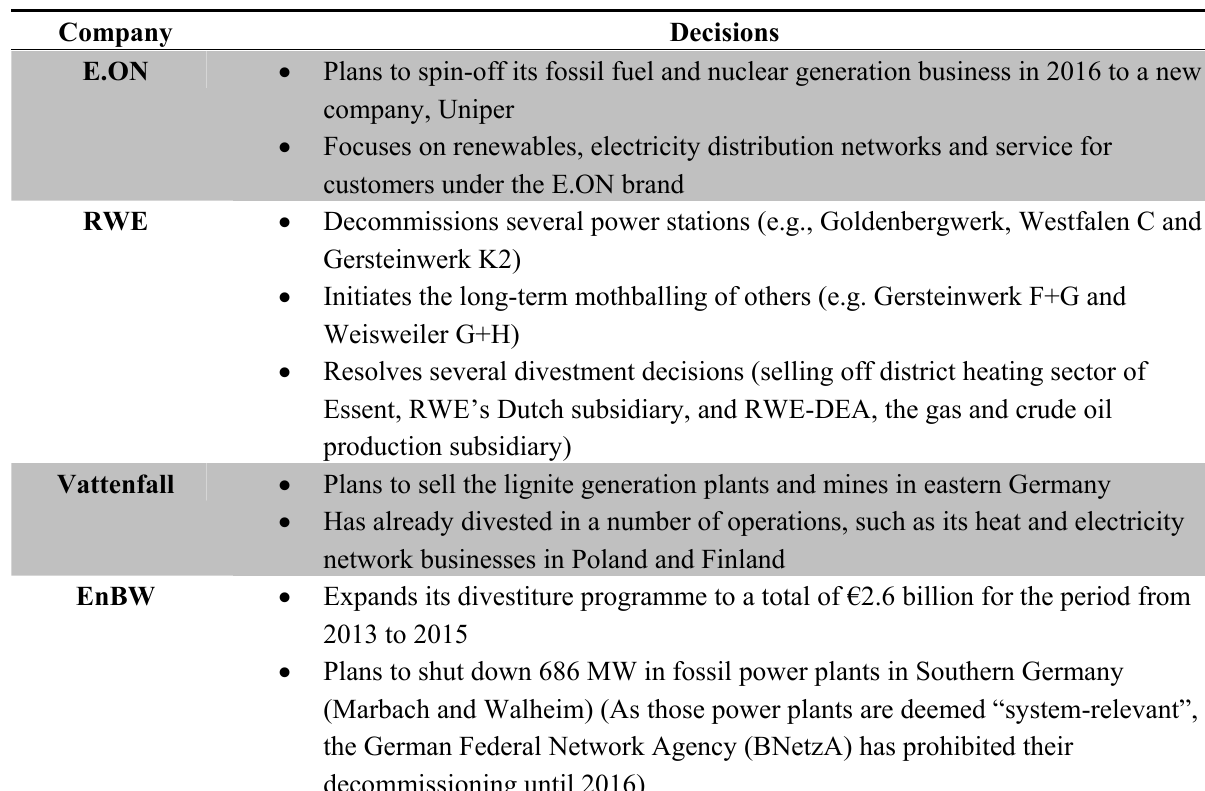
Table 2. The four companies’ decisions to remove selected fossil fuel operations from their portfolio [17,18].